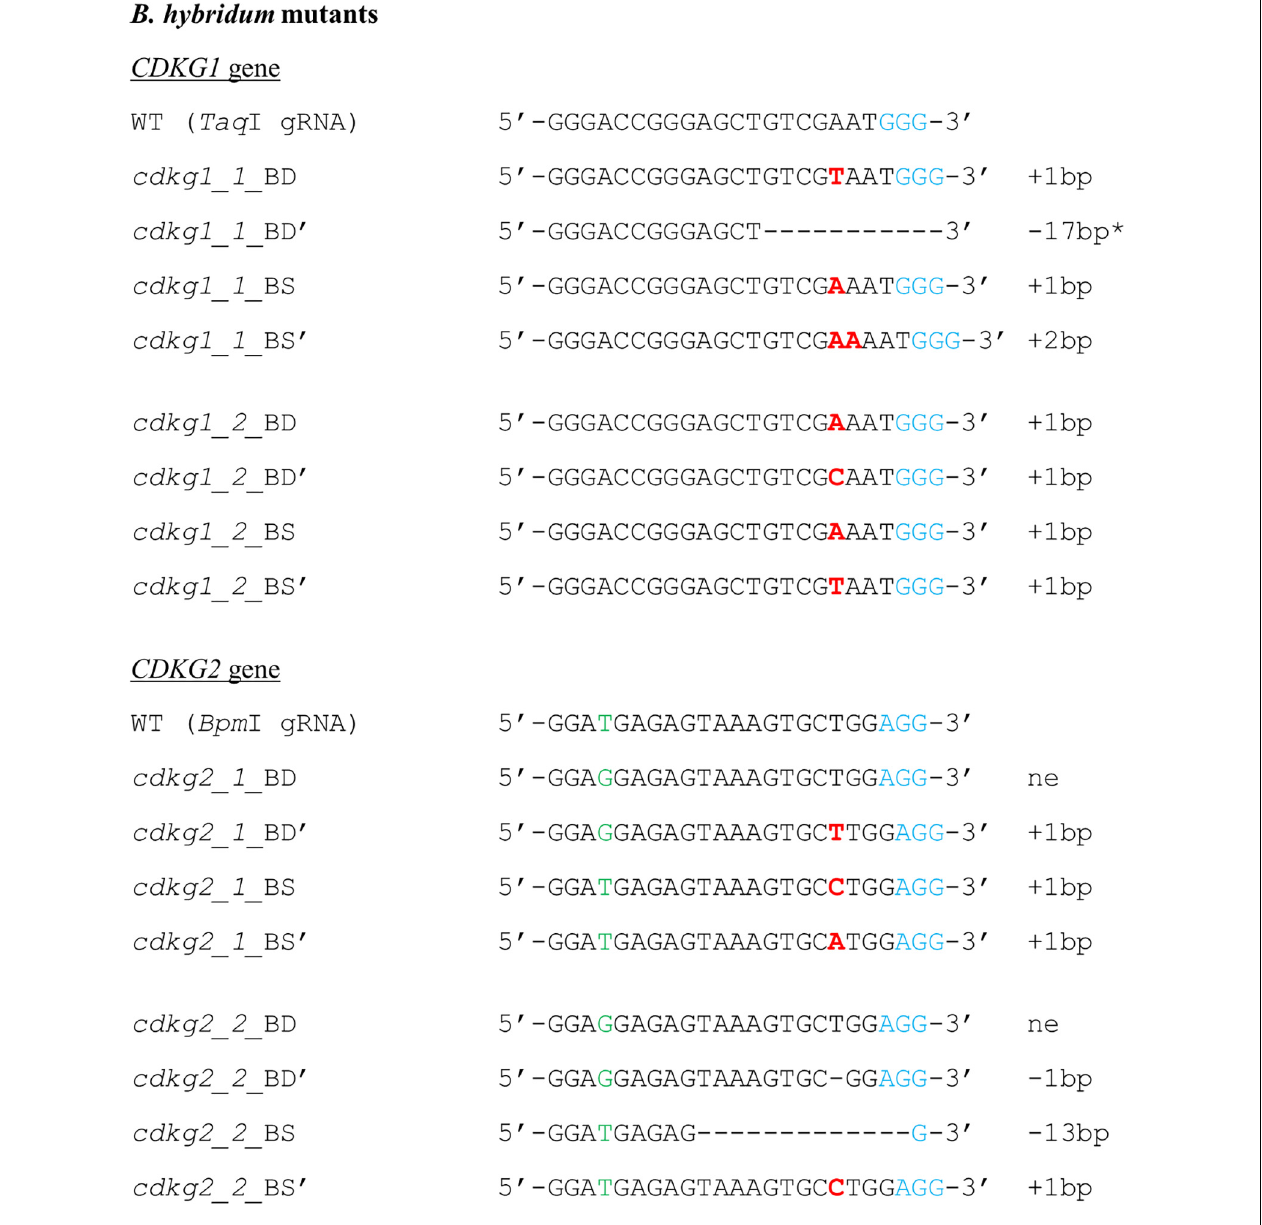
FIGURE 8 | Nature of mutations obtained using CRISPR/Cas9 targeted mutagenesis in T0 plants of B. hybridum . Deletions are denoted as hyphens (-) and insertions as bold red letters. The PAM sequence is shown in blue. Individual plants are marked with numbers. The sequences of both alleles are presented and marked as BD, BD’ or BS, BS’. SNP in the target sequence of Bd and Bs genomes is shown in green. * - the mutation goes beyond the gRNA sequence. bp – base pairs, ne – not edited